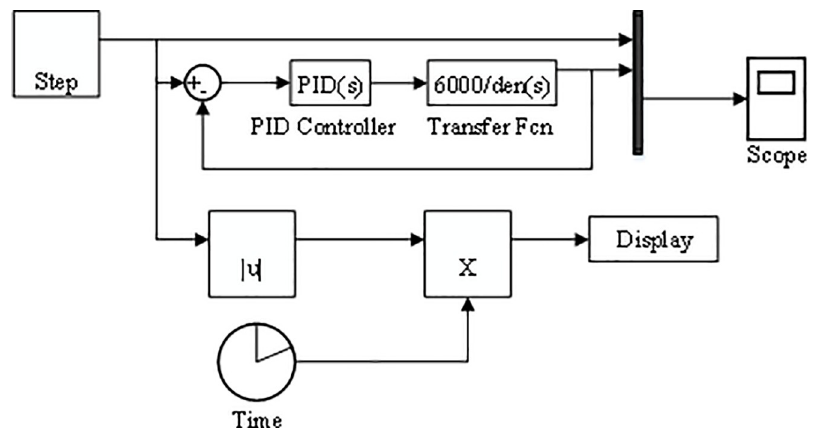
Fig 3. Model of PID control